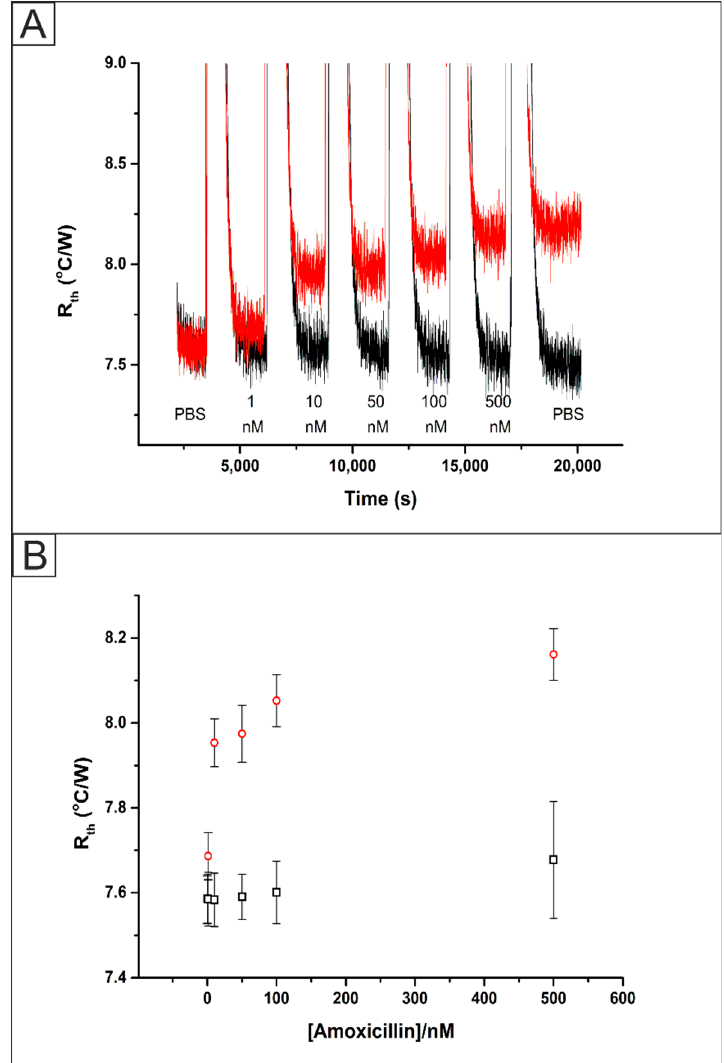
Figure 5. ( A ) The raw HTM data plot of R th versus time for the addition of amoxicillin (1–500 nM) in PBS to an SPE functionalised with a direct UV polymerized MIP (red) and NIP (black). ( B ) Comparison between the absolute R th values obtained from the HTM for a MIP functionalised SPE (red circles) and NIP functionalised SPE